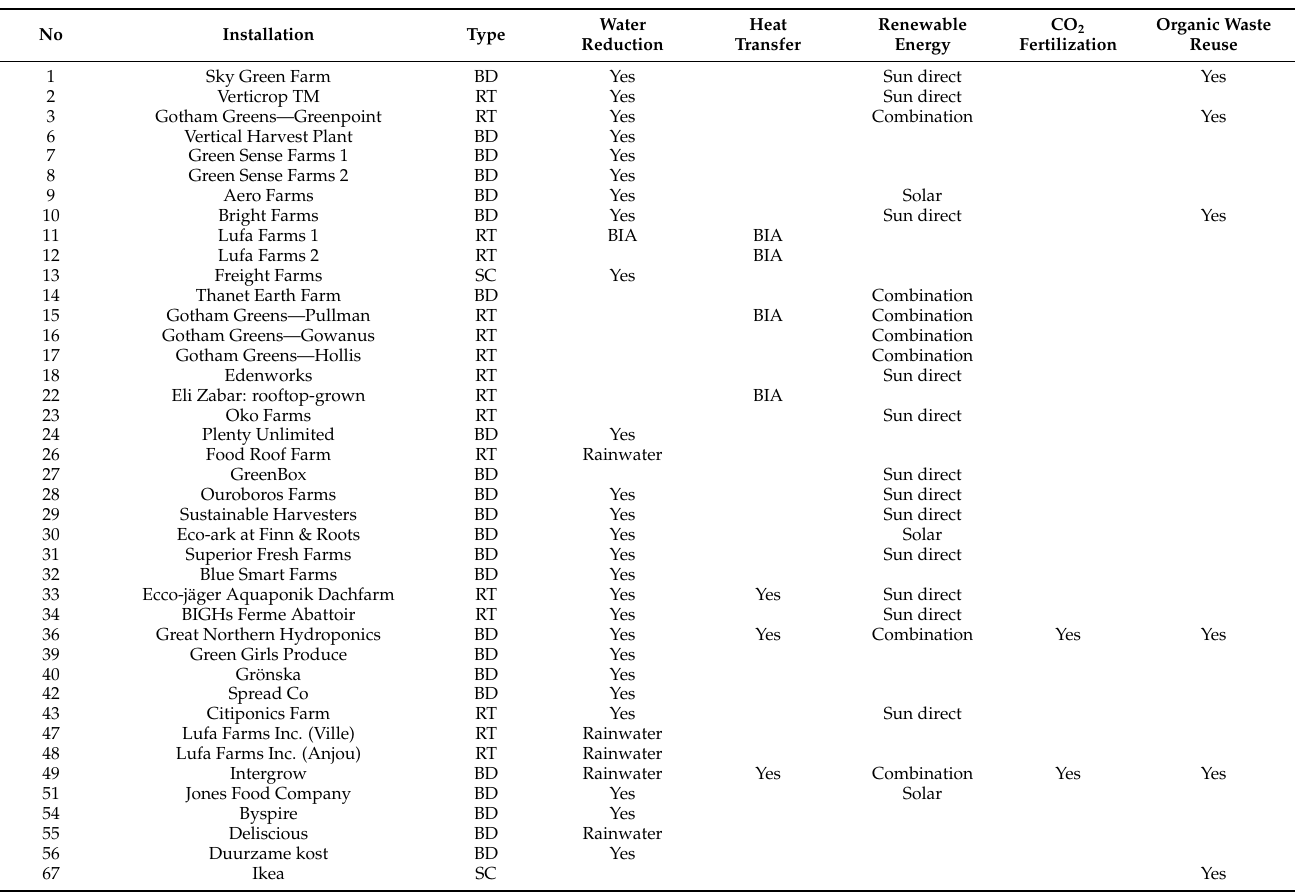
Table 3. This is a table of the sample of active installations with the location type and the described benefits are noted as ‘yes’ to indicate that the benefit was duly documented and ‘BIA’ when building integration was identified. Blank cells indicate that no information was documented and cases without any benefits were removed. Installation locations are BD: Inside a Building, RT: Rooftop of a Building, SC: Shipping Container, CC: Climate Chamber. Renewable energy options included Solar: for generation with photo-voltaic, Sun Direct: for sites using sunlight during the day, Combination: a combination of renewable energy technology was identified, such as biogas generation combined with sun